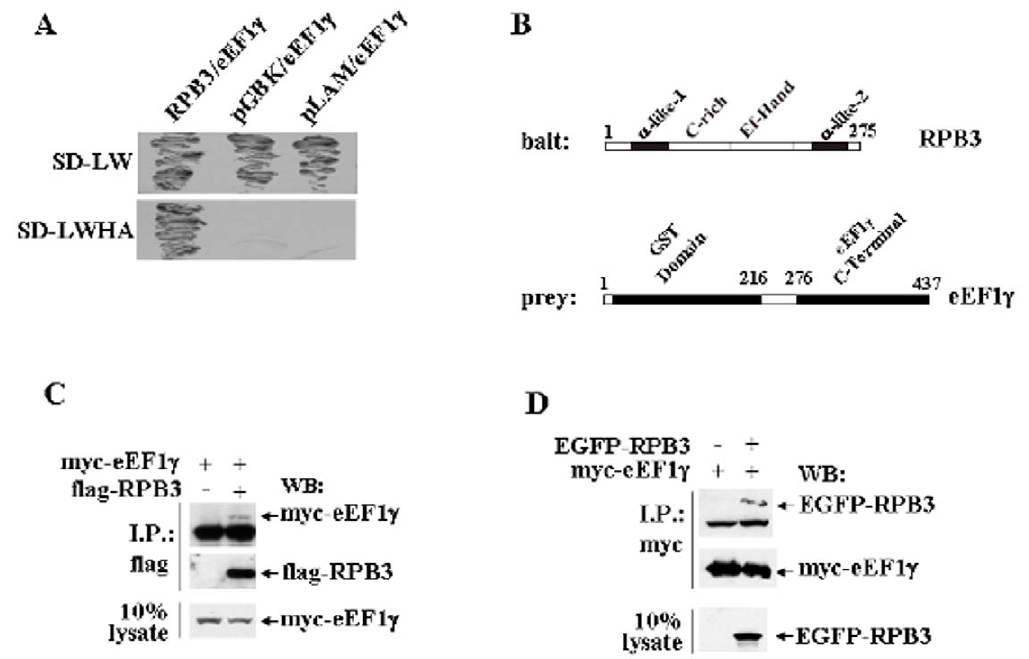
Figure 1. RPB3 interacts with eEF1 c . A : Yeast two hybrid assay: AH109 yeast cells were co-transformed with the indicated constructs and plated onto SD media lacking leucine and tryptophan (-LW) to verify the expression of both bait (W + ) and prey (L + ) plasmids, or onto media lacking leucine, tryptophan, histidine and adenine (-LWHA) to examine the interaction between bait and prey proteins. B : Schematic representation of full-length proteins of both bait (RPB3) and prey (eEF1 c ). C : Whole cell extracts of HeLa cells transfected with either myc-eEF1 c or flag-RPB3 and myc-eEF1 c were immunoprecipitated with the anti-flag monoclonal antibody and the co-immunoprecipitation was analysed by western blot using the anti-myc monoclonal antibody. The myc-eEF1 c signal is above the heavy chain Ig band. D : Whole cell extracts of HeLa cells transfected with either myc-eEF1 c or with myc-eEF1 c and EGFP-RPB3 were immunoprecipitated with the anti-myc monoclonal antibody and the co-immunoprecipitation was analysed by western blot using the anti-EGFP monoclonal antibody. The EGFP-RPB3 signal is above the heavy chain Ig band.